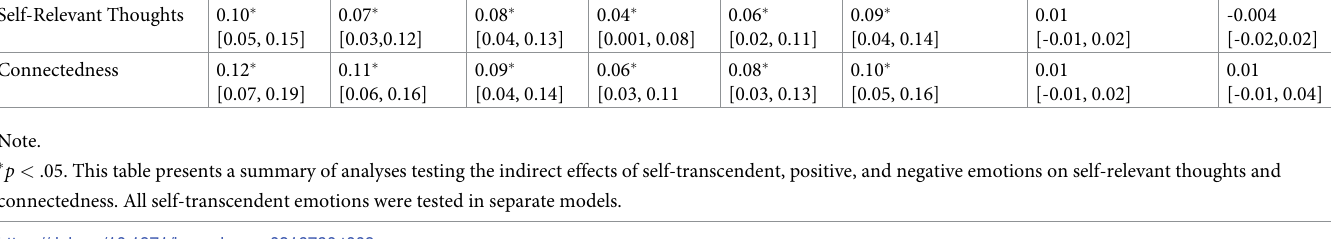
Table 3. Indirect effects of self-transcendent emotions on self-relevant thoughts and connectedness (Study 1).